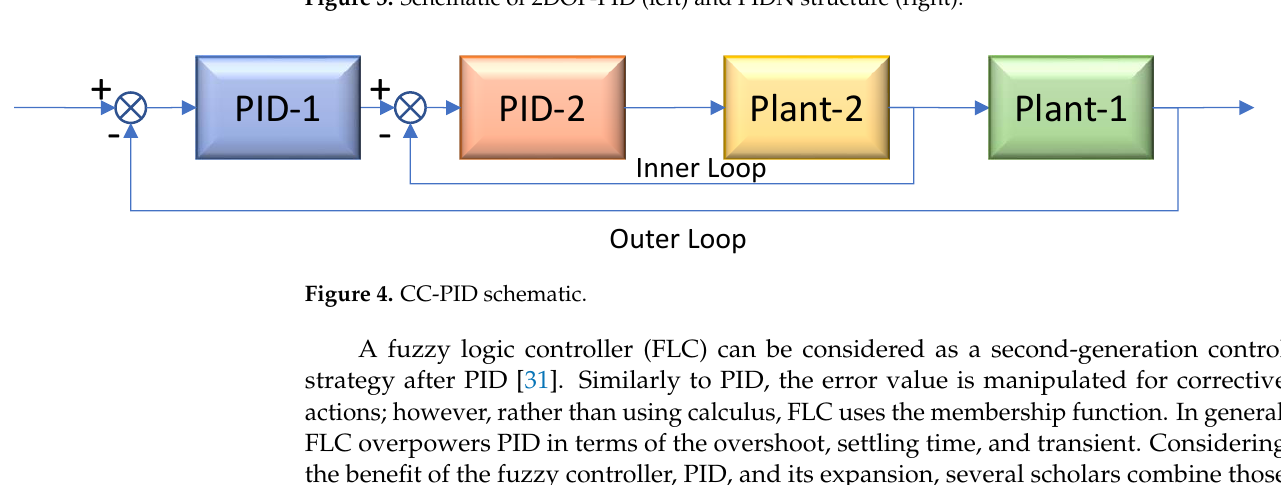
Figure 3. Schematic of 2DOF-PID (left) and PIDN structure (right).